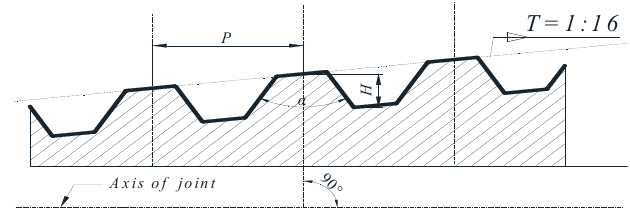
Figure 1. Schematic diagram of the thread profile.